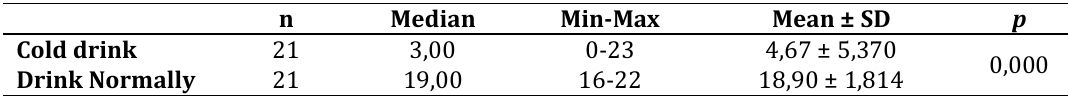
Difference in post-test score between control and treatment